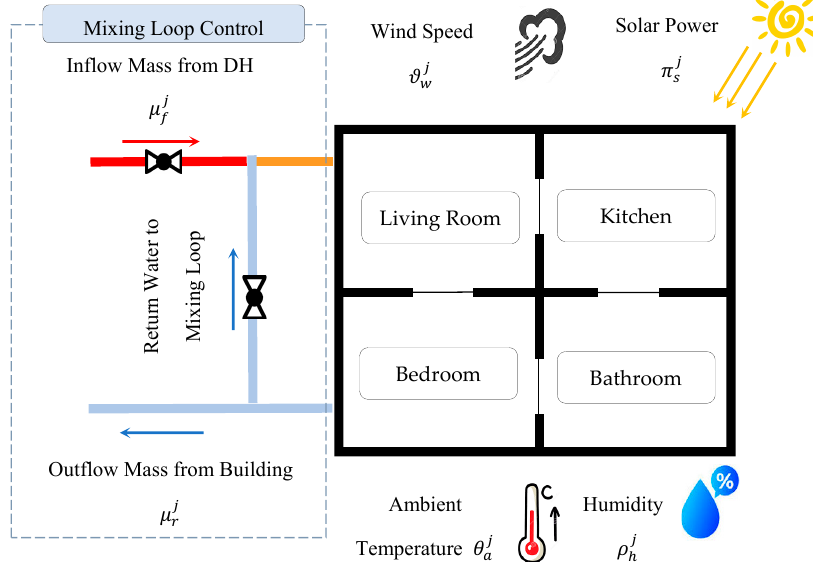
Figure 1. A detached house supplied by mixing loop with weather disturbances.